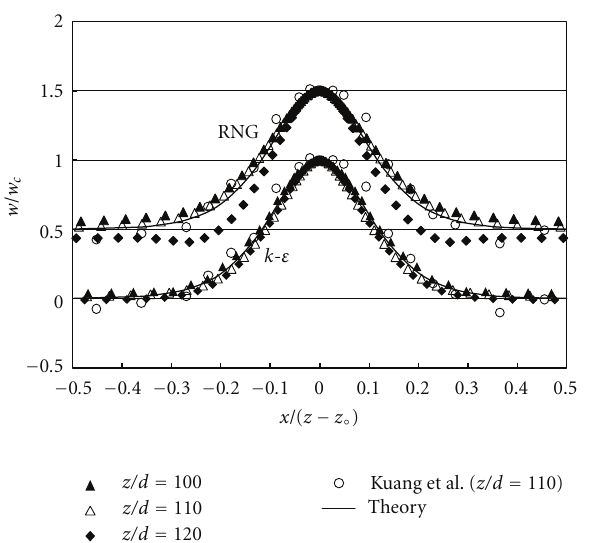
Figure 7: Profiles of longitudinal velocity in ZSI.